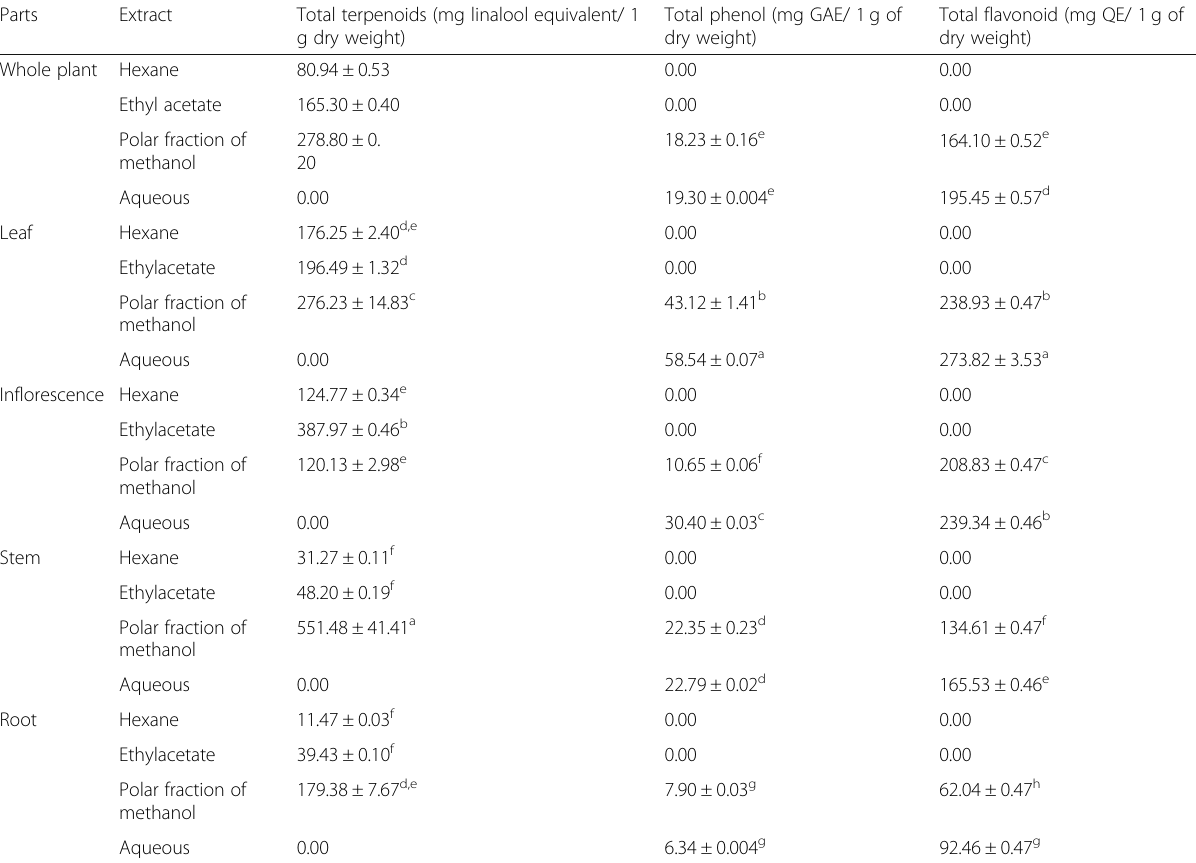
Table 6 Total terpenoids, total phenols and total flavonoids in different parts and extracts of Sphaeranthus indicus